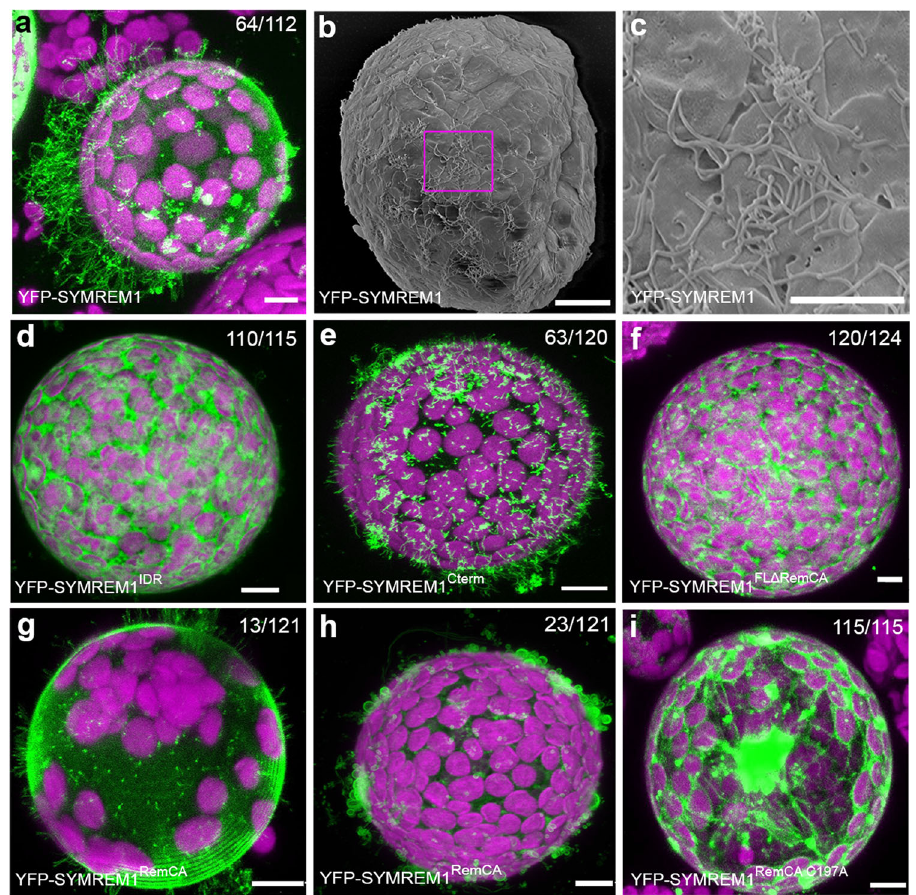
Fig. 4 | SYMREM1 stabilizes membrane tubulation and curvature in a cell wall- independentmanner.a – c N.benthamiana leafprotoplastsectopically expressing YFP-SYMREM1 develop multiple membrane tubes as shown by confocal laser- scanning microscopy ( a ) and scanning electron microcopy ( b ) and close-up in ( c ). d – i Protoplasts expressing different SYMREM1 variants: only IDR domain (SYM- REM1 IDR , d ), only C-terminal including RemCA (SYMREM1 Cterm , e ), full-length sequence lacking the RemCA domain (SYMREM1 FL Δ RemCA , f ), RemCA domain